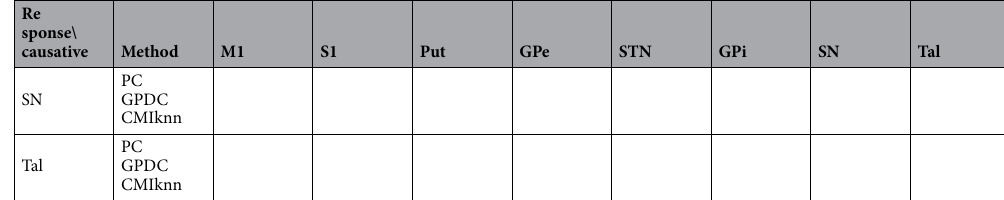
Table 1. Statistical values of each functional link during the resting-task computed with the partial correlation (PC), gaussian process regression and distance correlation (GPDC), and conditional mutual information test (CMIknn) methods. Columns correspond to causative nuclei and rows to response nuclei. Only those relationships with p -values < 0.01 are shown. All the statistical values in this table were normalized between 0 and 1, a procedure that facilitates the comparison of the results obtained with the three methods. M1 primary motor cortex, S1 primary somato-sensory cortex, Put putamen, GPe external globus pallidum,